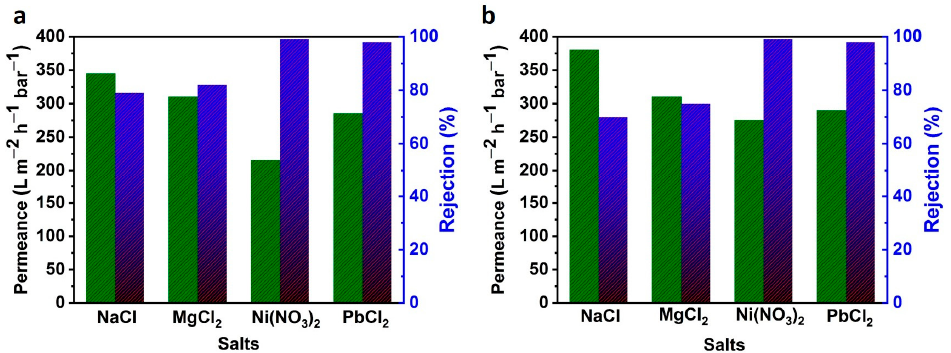
Table 2. Separation performance of the GO nanocomposite membranes for various salts at 25 °C.